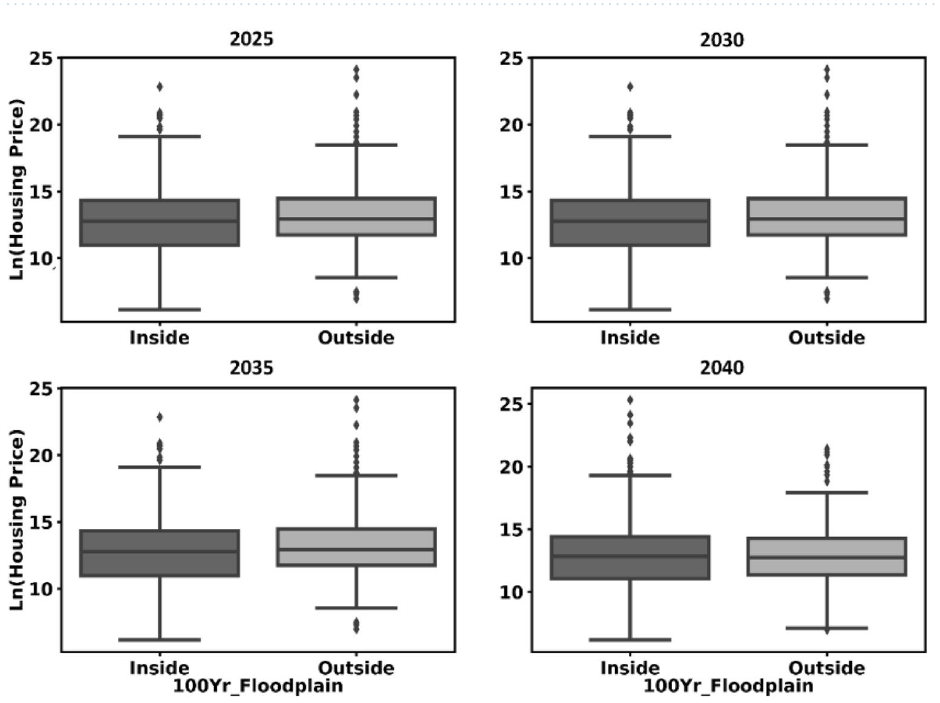
Figure 3. Projection of sale transactions (in natural log) from 2020 to 2040 for housing inside and outside the 100-year